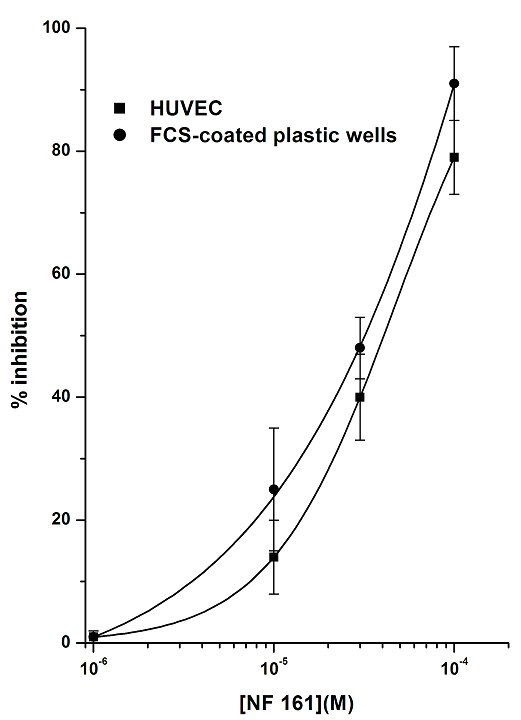
Effects of NF161 on PMN adhesion to FCS-coated plastic wells compared with PMN adhesion to HUVEC. PMNs were incubated with increasing concentrations (10-6–10-4M) of the tested compound for 10 min at 37°C and then challenged with FMLP 10-7M for 10 min. FMLP stimulation vs control was: 323 ± 33%. Data are expressed as percentage inhibition versus control adhesion, as means ± SEM; n = 5.